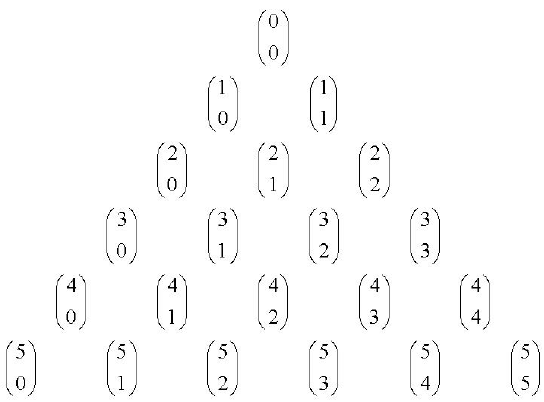
Figure 43: The first six rows of Pascal’s triangle as Binomial Coefl-